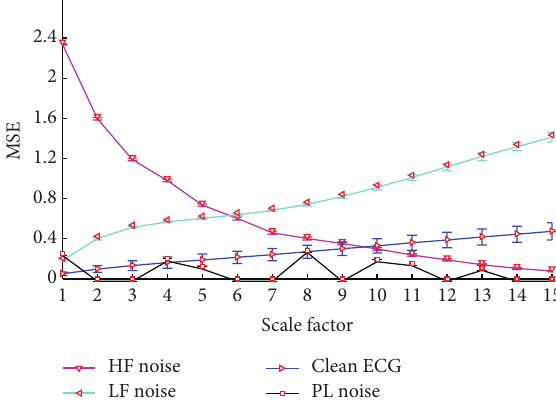
Figure 3: MSE of three typical noises and the clean ECG with scale factor from 1 to